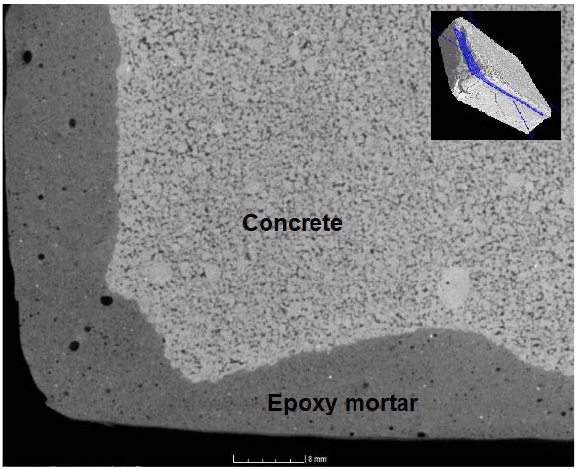
Figure 25. CT scan of the corner reprofiled by the epoxy composite containing the fly ash with the location indicating of the scan in the sample—perpendicular plane of the cut.